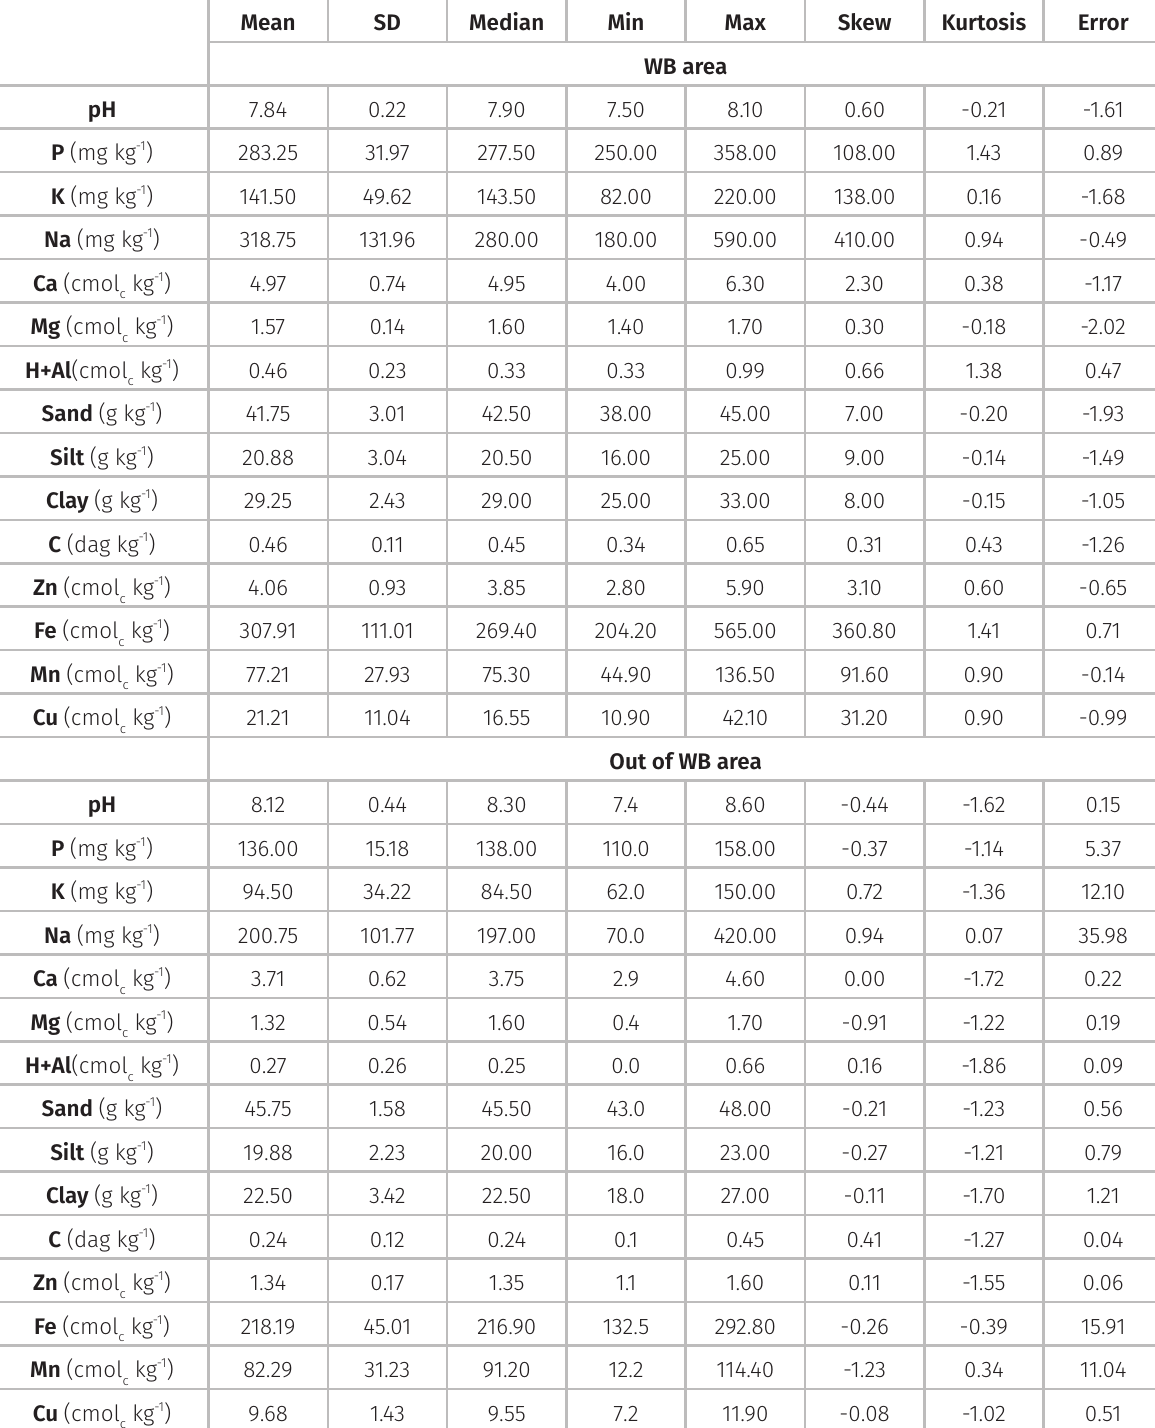
Table I. Soil chemical attributes of in the whale skeleton area (WB area) and outside of the influence of whale bones (outside of the WB area) on the Keller